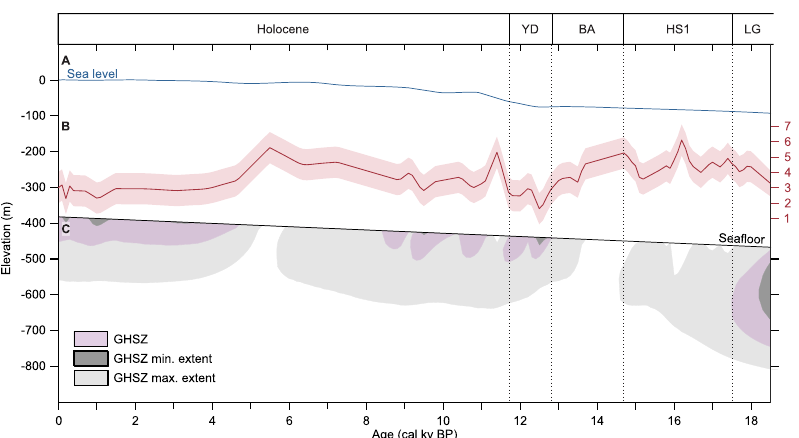
Fig. 4 Impact of input parameters on the modeled gas hydrate stability zone (GHSZ). A Evolution of sea level 61 ; ( B ) Reconstructed bottom water temperature (BWT) sampled every 100 years; ( C ) Minimum and maximum variation in the GHSZ. Uncertainties in BWT, thermal gradient, porewater salinity, and thermal properties are listed in Table S1. LG: Late Glacial; HS1: Heinrich Stadial 1; BA: Bølling-Allerød interstadials; YD: Younger